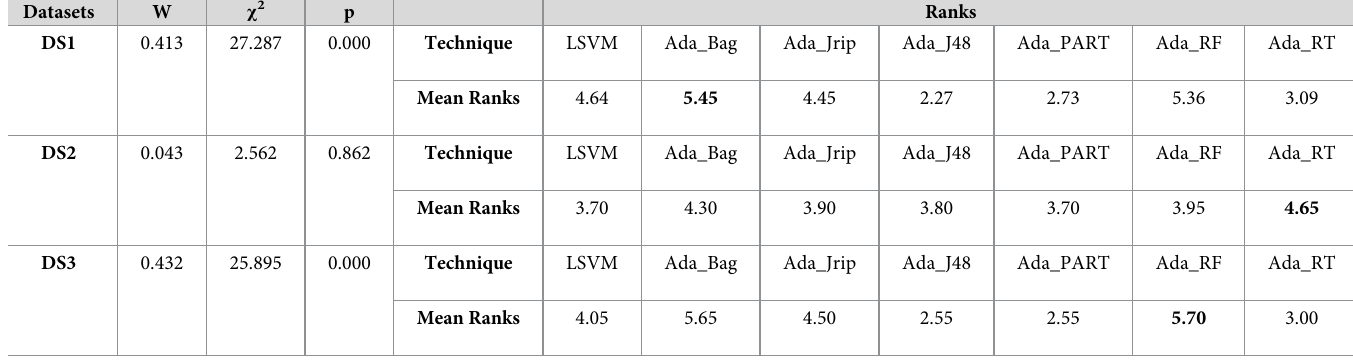
Table 14. Rankings of existing best performing classifier (LSVM) and AdaBoost ensemble classifiers, based on Kendall’s W test results using the MDDR dataset by specificity measure. Datasets